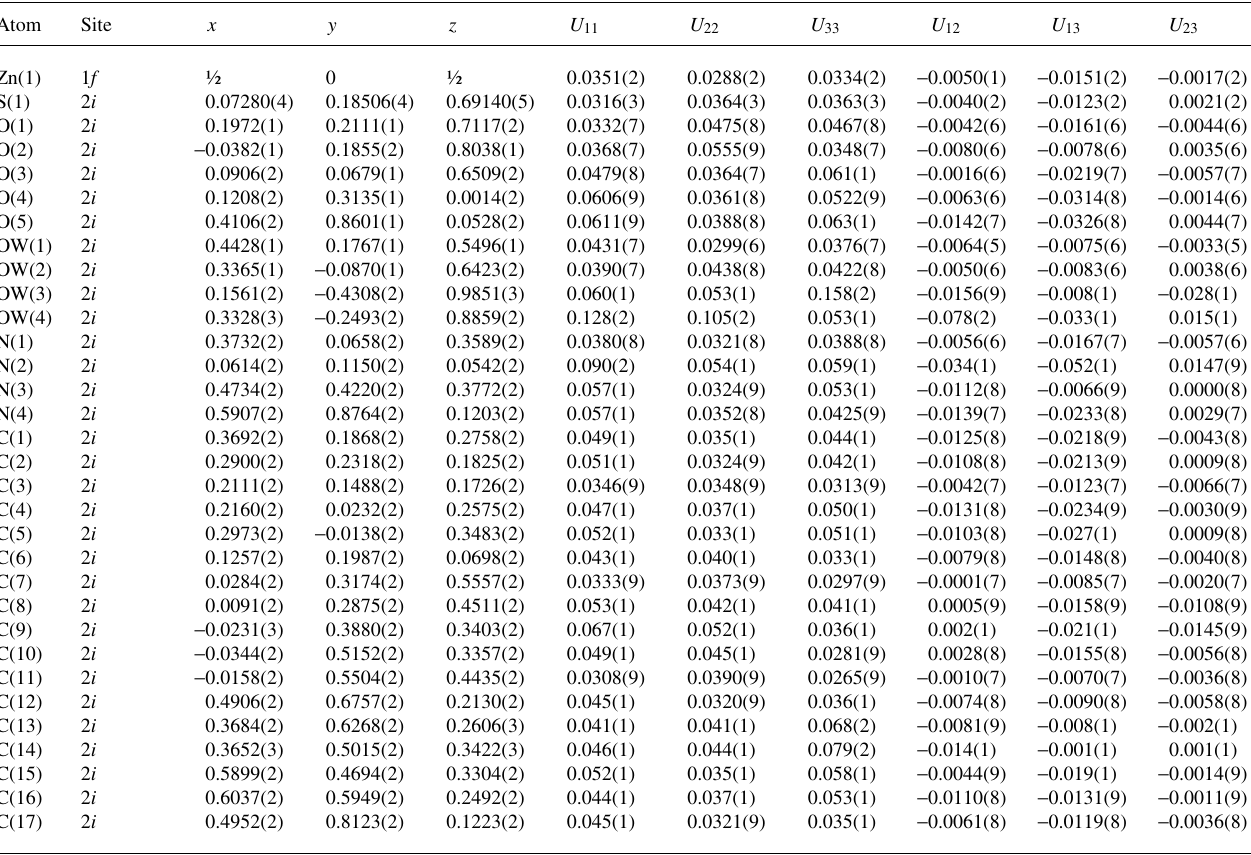
Table 3. Atomic coordinates and displacement parameters (in Å 2 ) .